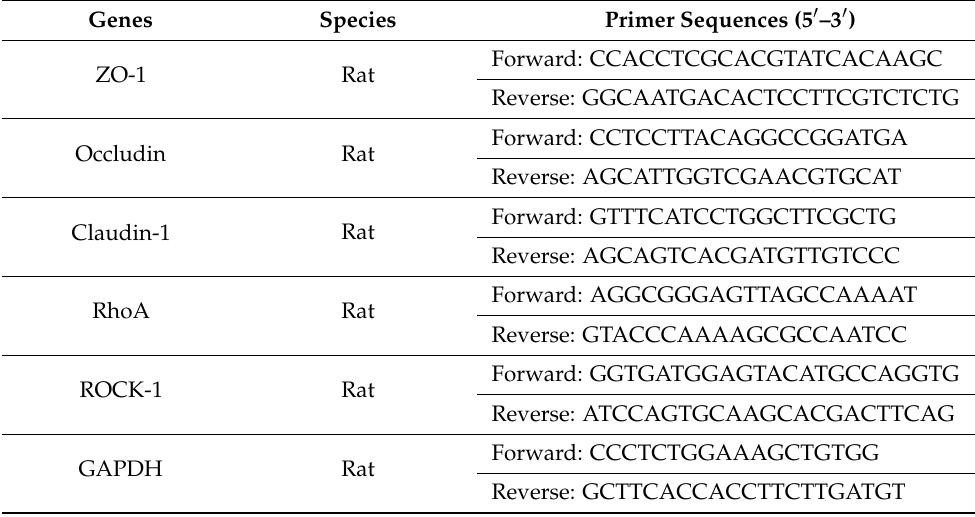
Table 1. The sequences of the primers used in the RT-qPCR